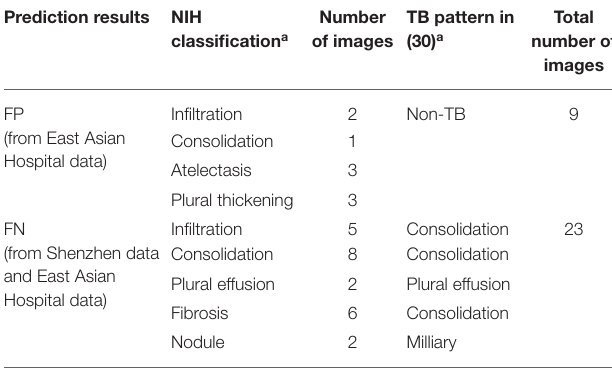
TABLE 7 | Sub-patterns for false positive (FP) and false negative (FN) results in